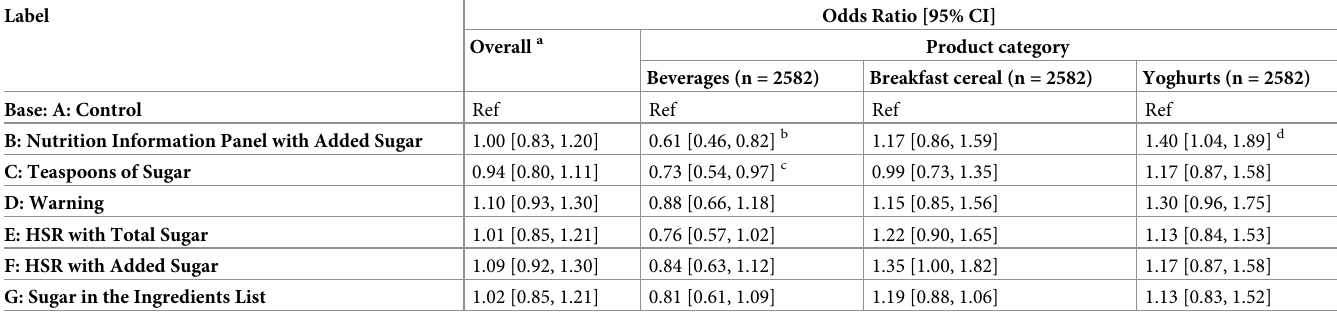
Table 2. Effect of added sugar labels on selection of a high sugar product, by food category (n = 2582).